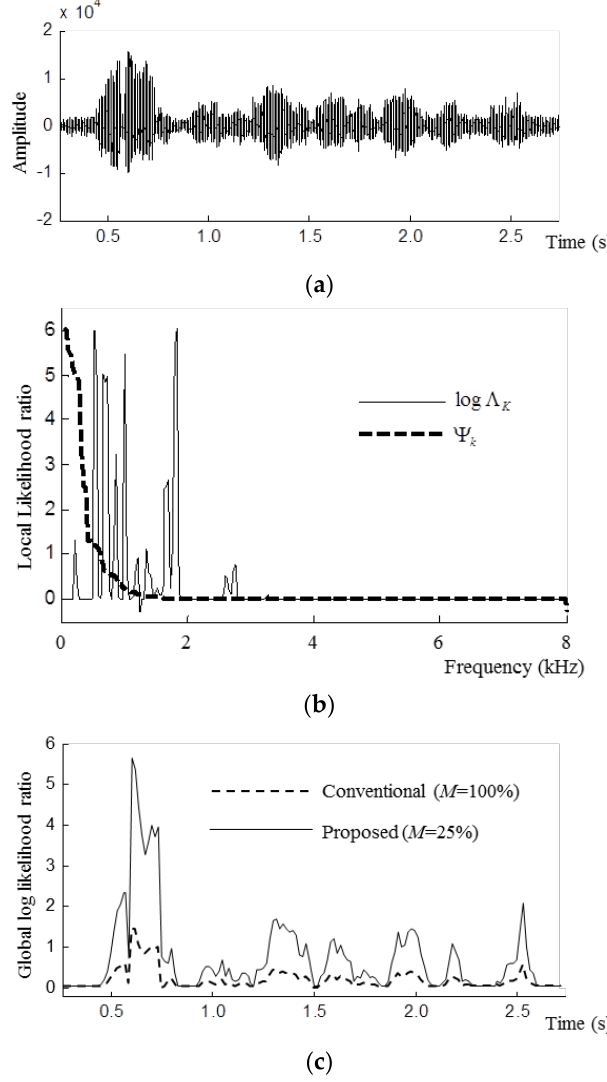
Figure 2. Step-by-step illustration of ( a ) waveform of babble noisy speech at 5 dB signal-to-noise ratio (SNR), ( b ) local likelihood ratio (LR) estimates of the frequency, and ( c ) global log LR estimates of the time.